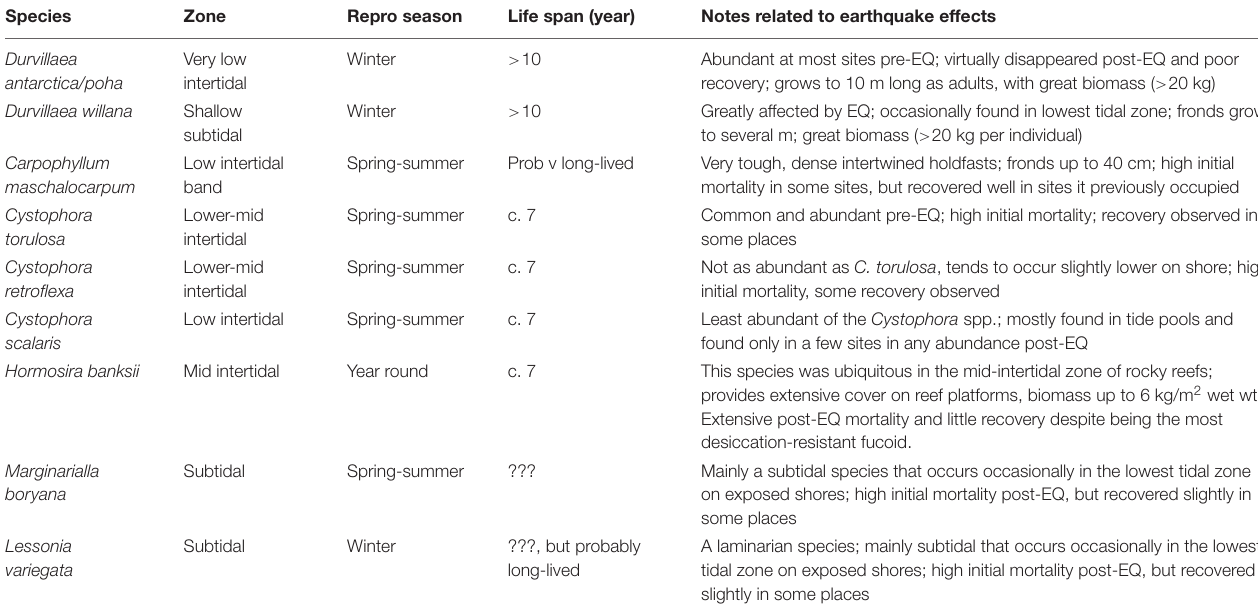
TABLE 1 | Key habitat-forming large brown algae in the study